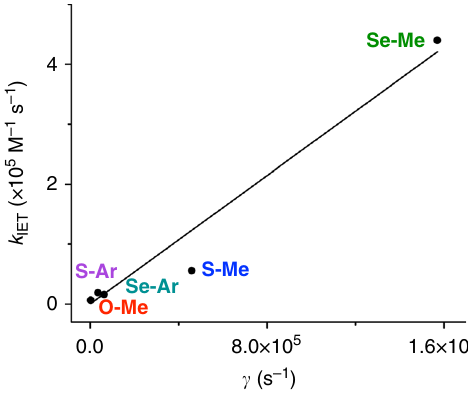
Fig. 5 Relationship between k IET and the pseudo-rate constant γ proportional to k Marcus . A plot of k IET for the indicated compounds as a function of the pseudo-rate-constant, γ , calculated analogously to k Marcus but substituting Ac A,X S ° DA for H DA (equation 10). The black line is a linear fi t of the data with the x and y intercepts held at 0 (adj. R 2